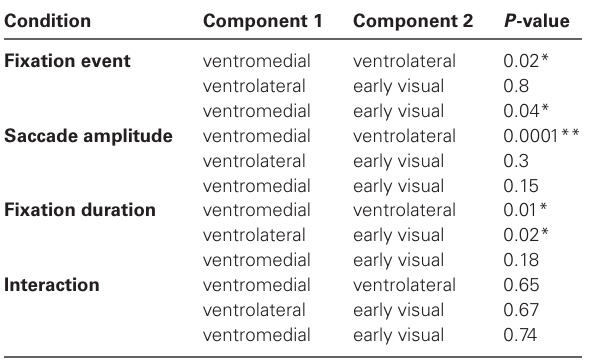
Table 1 | Results per condition from all paired t -tests performed between the effect sizes of all three components against all other effect sizes .